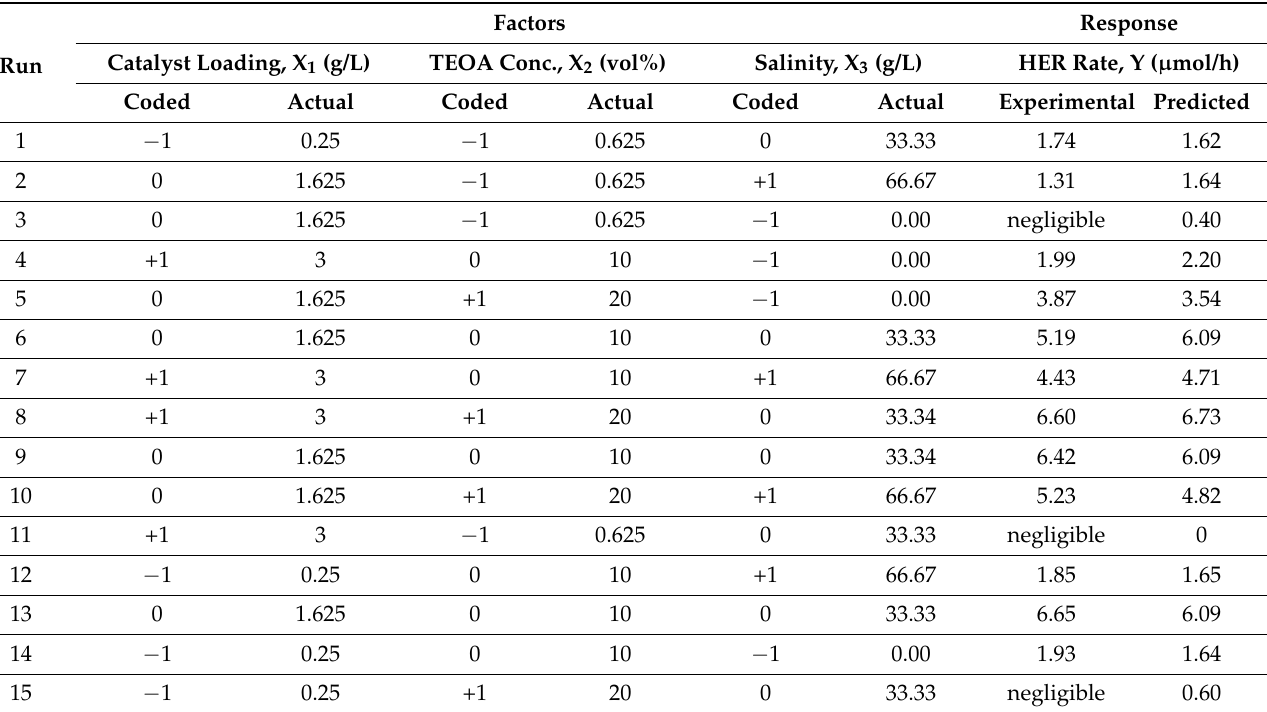
Table 3. Design matrix, experimental determined and predicted responses for the HER in